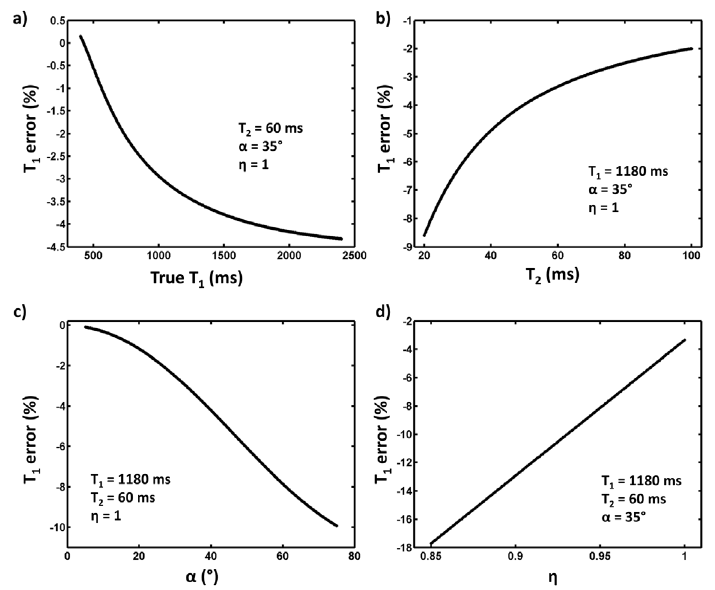
Fig 2. Deviation between true T1 values and T1 values determined by the standard post-processing approach as a function of T1 (a), T2 (b), nominal flip angle (c), and inversion efficacy η (d). The first dataset was generated using T2 = 60 ms, α = 35°, η = 1, the second with α = 35°, η = 1, T1 = 1180 ms, the third with T1 = 1180 ms, T2 = 60 ms, η = 1 and the fourth with T1 = 1180 ms, T2 = 60 ms, α = 35°. For each set of parameters, the 11 MOLLI points were reordered as a function of TI, and the 3-parameter model was adjusted on the recovery curve. T1 was then calculated (T1 = T1 * ×(B/A-1)) and compared to the true T1.